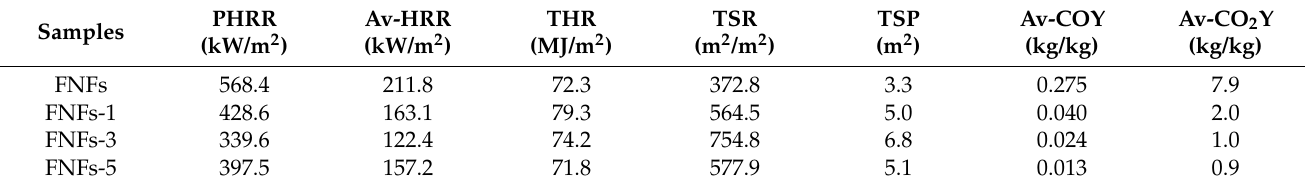
Figure 5. ( a ) Vertical combustion behavior of FNFs, ( b , c ) vertical combustion behavior of FNFs-4 ignited twice.